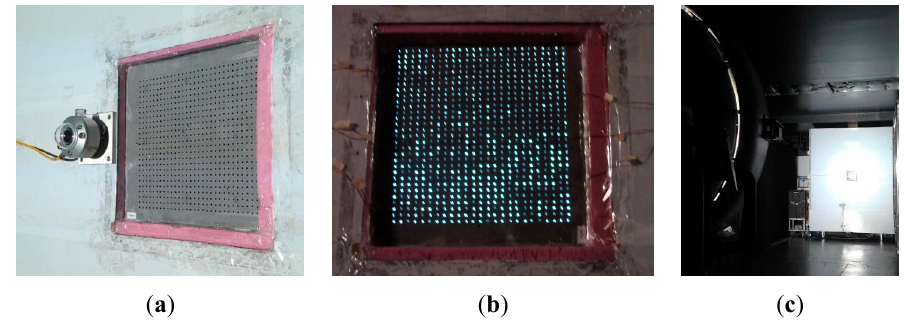
Figure 10. Test overview (note: indoor and outdoor denote inside and outside the CHB, respectively): ( a ) view from the indoor side; ( b ) view from the indoor side; ( c ) illumination of the TCP.